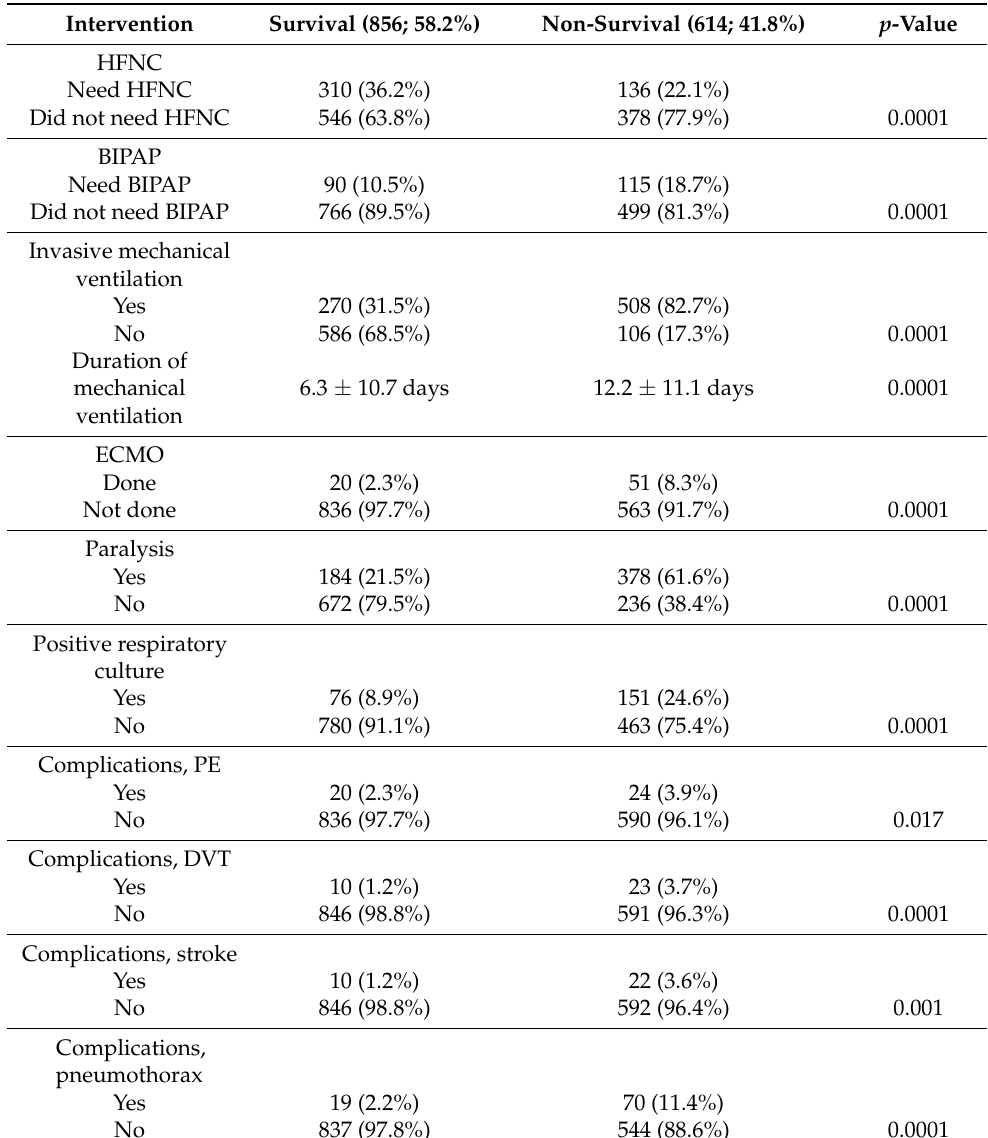
Table 2. Intervention and overall outcomes of patients ( n =